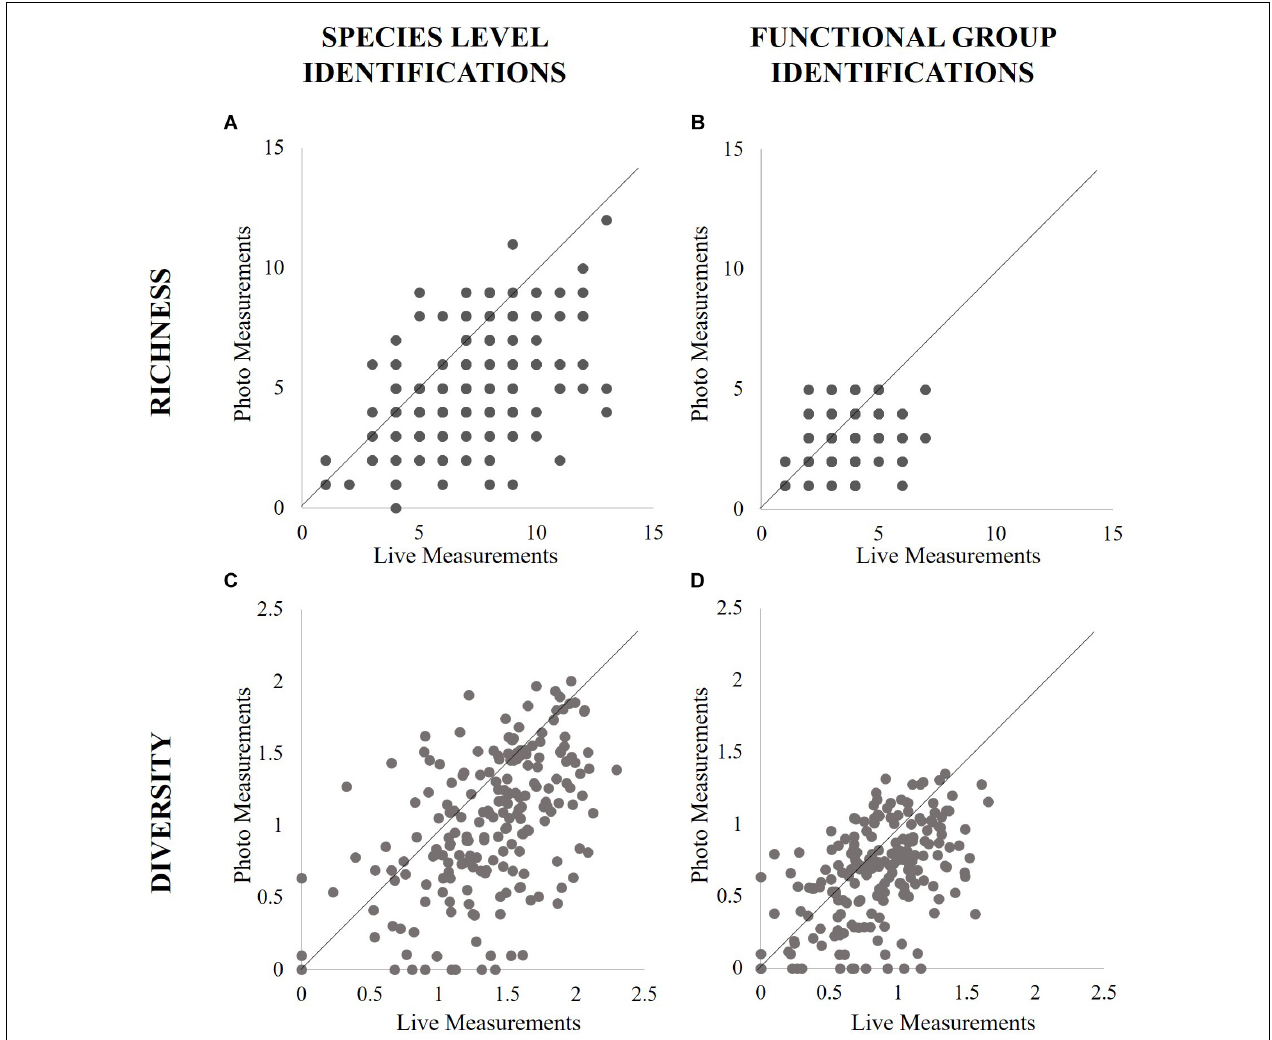
FIGURE 1 | Comparison of the spread of richness scores found by species identification (A) and functional group identification (B) and diversity scores found by species (C) and functional group (D) from all panels for both point count methods.